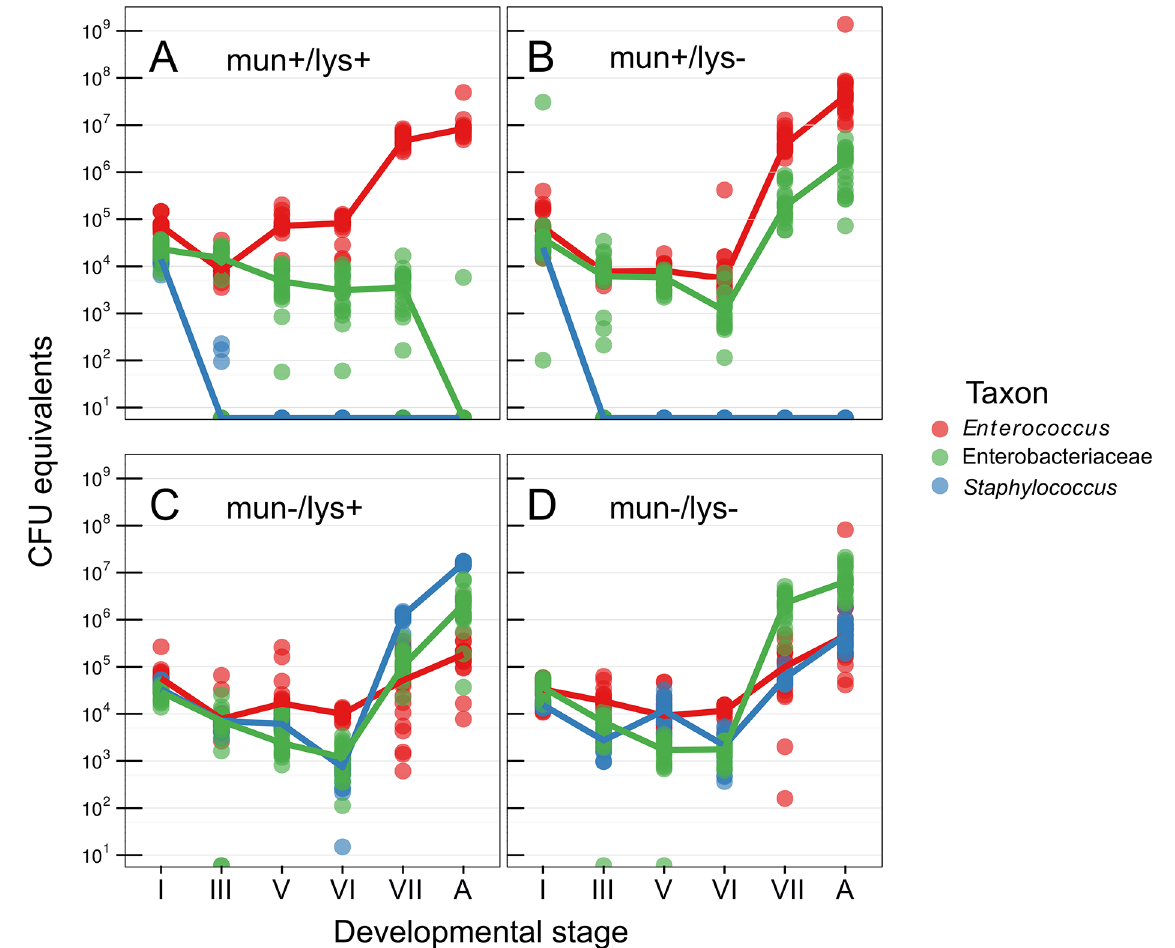
Fig 1. Abundance of bacteria during host metamorphosis. Using 16S rRNA gene qPCR the microbiota was sampled across metamorphosis in (A) wild- type hosts with bacteriocin-producing Entercoccus mundtii G2 symbiont, (B) immunocompromised hosts where RNAi was used to knock down lysozyme gene expression, (C) wild-type hosts with mutant Entercoccus mundtii symbionts that do not produce bacteriocin, and (D) both immunocompromised hosts and mutant symbionts. Roman numerals correspond to precise stages of the larval-pupal molt (see materials and methods). A, adult.